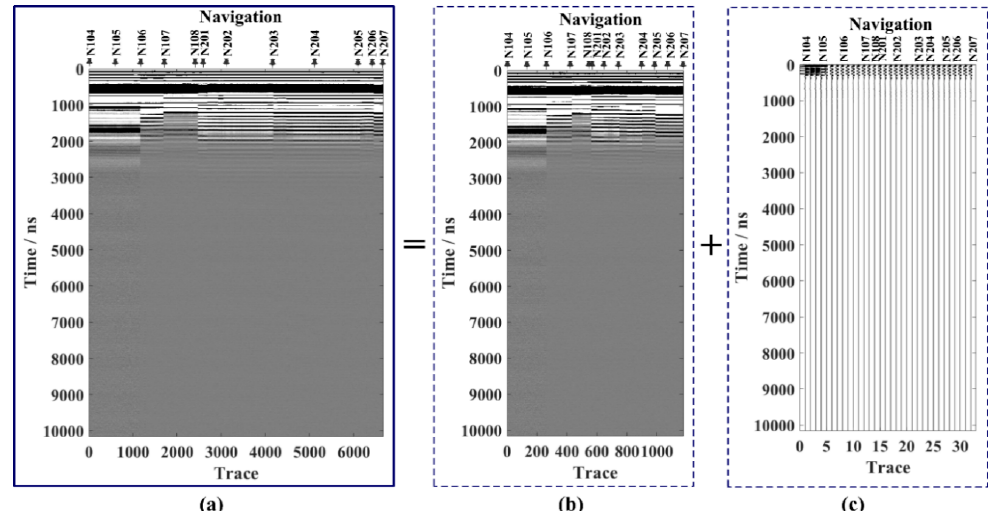
Figure 2. Lunar Penetrating Radar (LPR) CH-1 data from N104 to N207 after preprocessing. ( a ) All traces from N104 to N207. ( b ) The traces after deleting the repeated traces. ( c ) The stagnation traces at each recording and navigation point from N104 to N207.